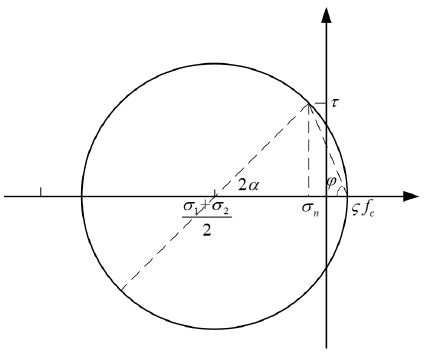
Figure 17. Mohr stress circle.